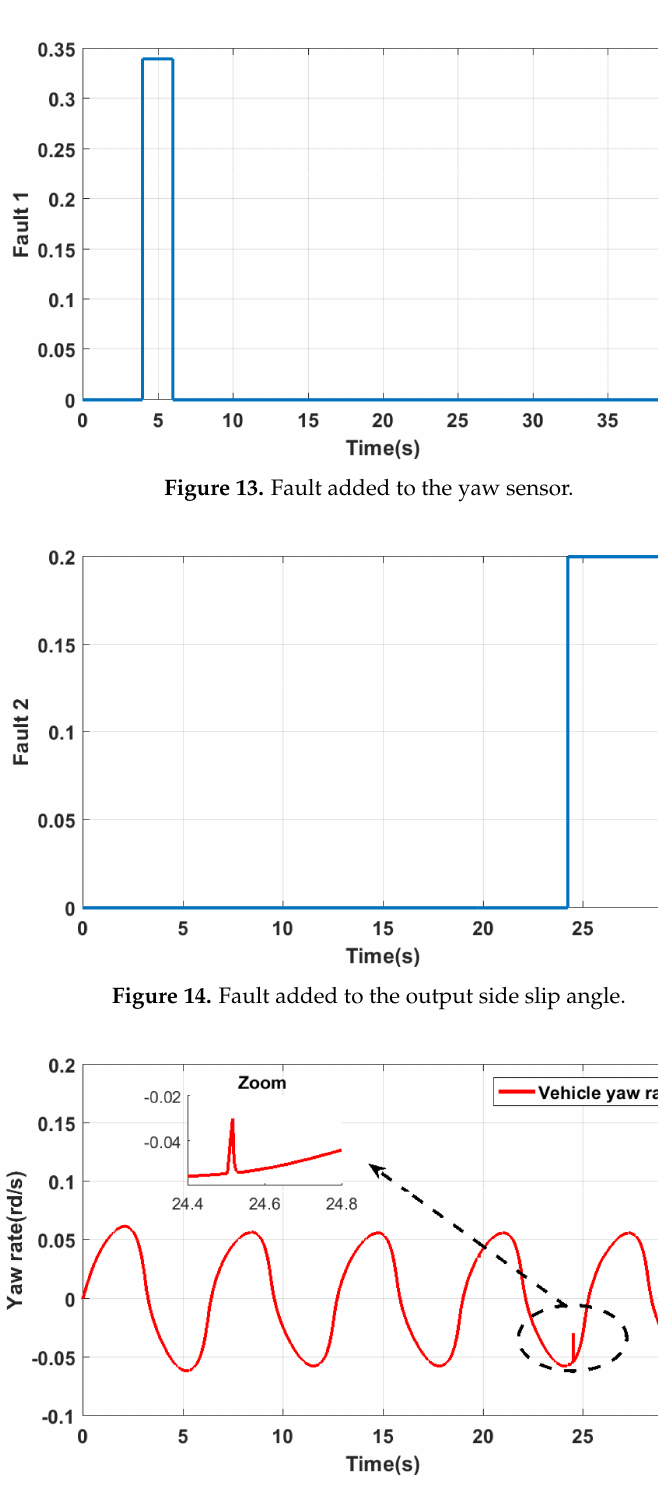
Figure 15. Vehicle output Yaw rate with